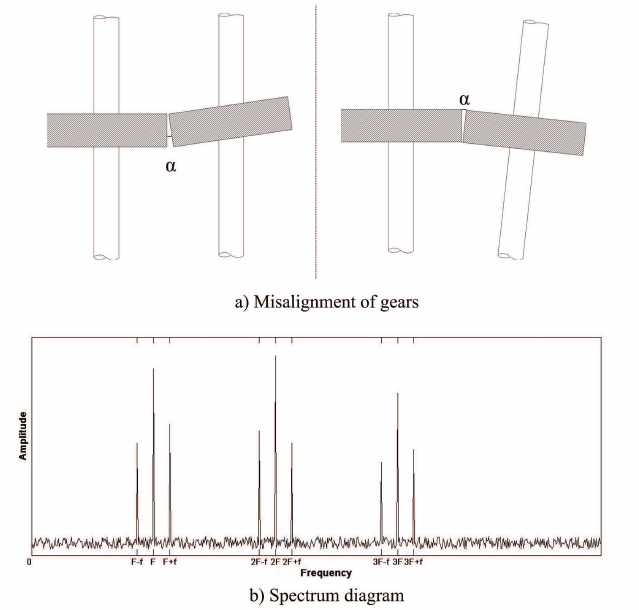
Figure 2. Gear misalignment fault and spectrum diagram. ( a ) Misalignment of gears. ( b ) Spectrum